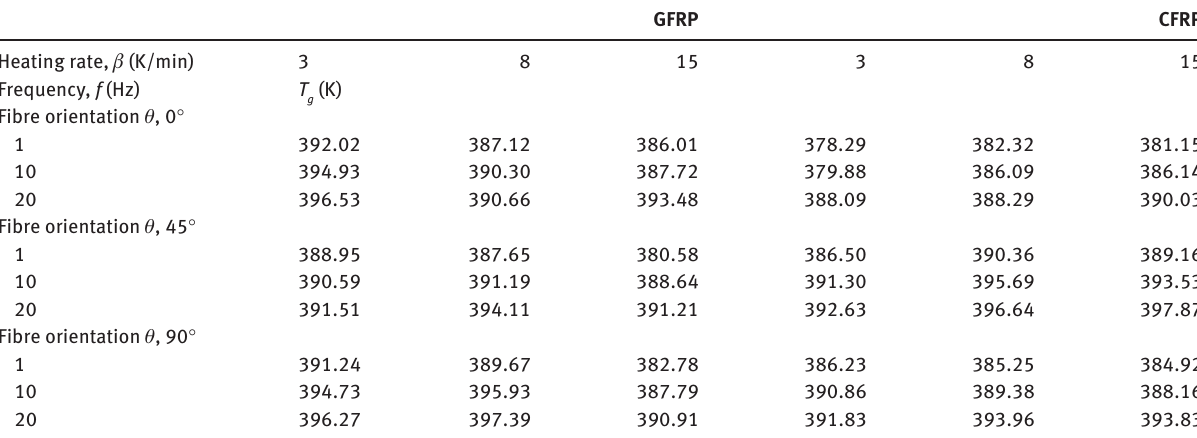
Table 3: Misestimation of T Heating rate, β (K/min)